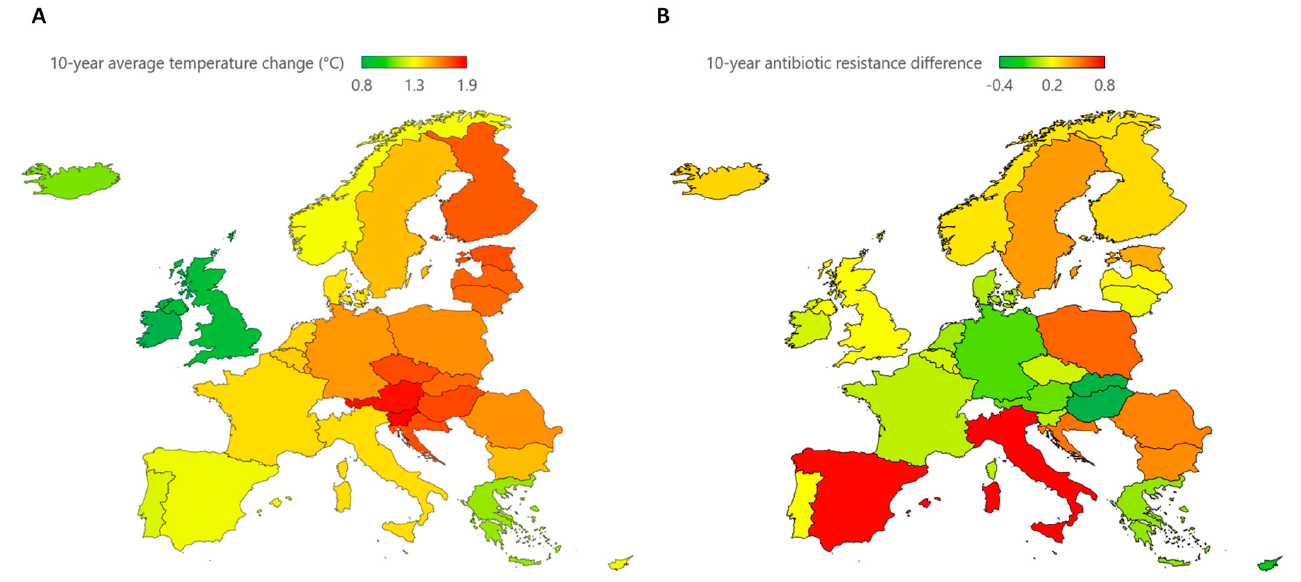
Figure 3. Ten-year temperature and antimicrobial resistance changes. ( A ) Map of the 10-year average temperature change ( ◦ C) across European countries; this summary measure was computed as the mean of annual temperature changes from 2010 to 2019; ( B ) map of the 10-year antimicrobial resistance difference across European countries (10-year antimicrobial resistance difference was computed as the difference of weighted averages between 2019 and 2010).